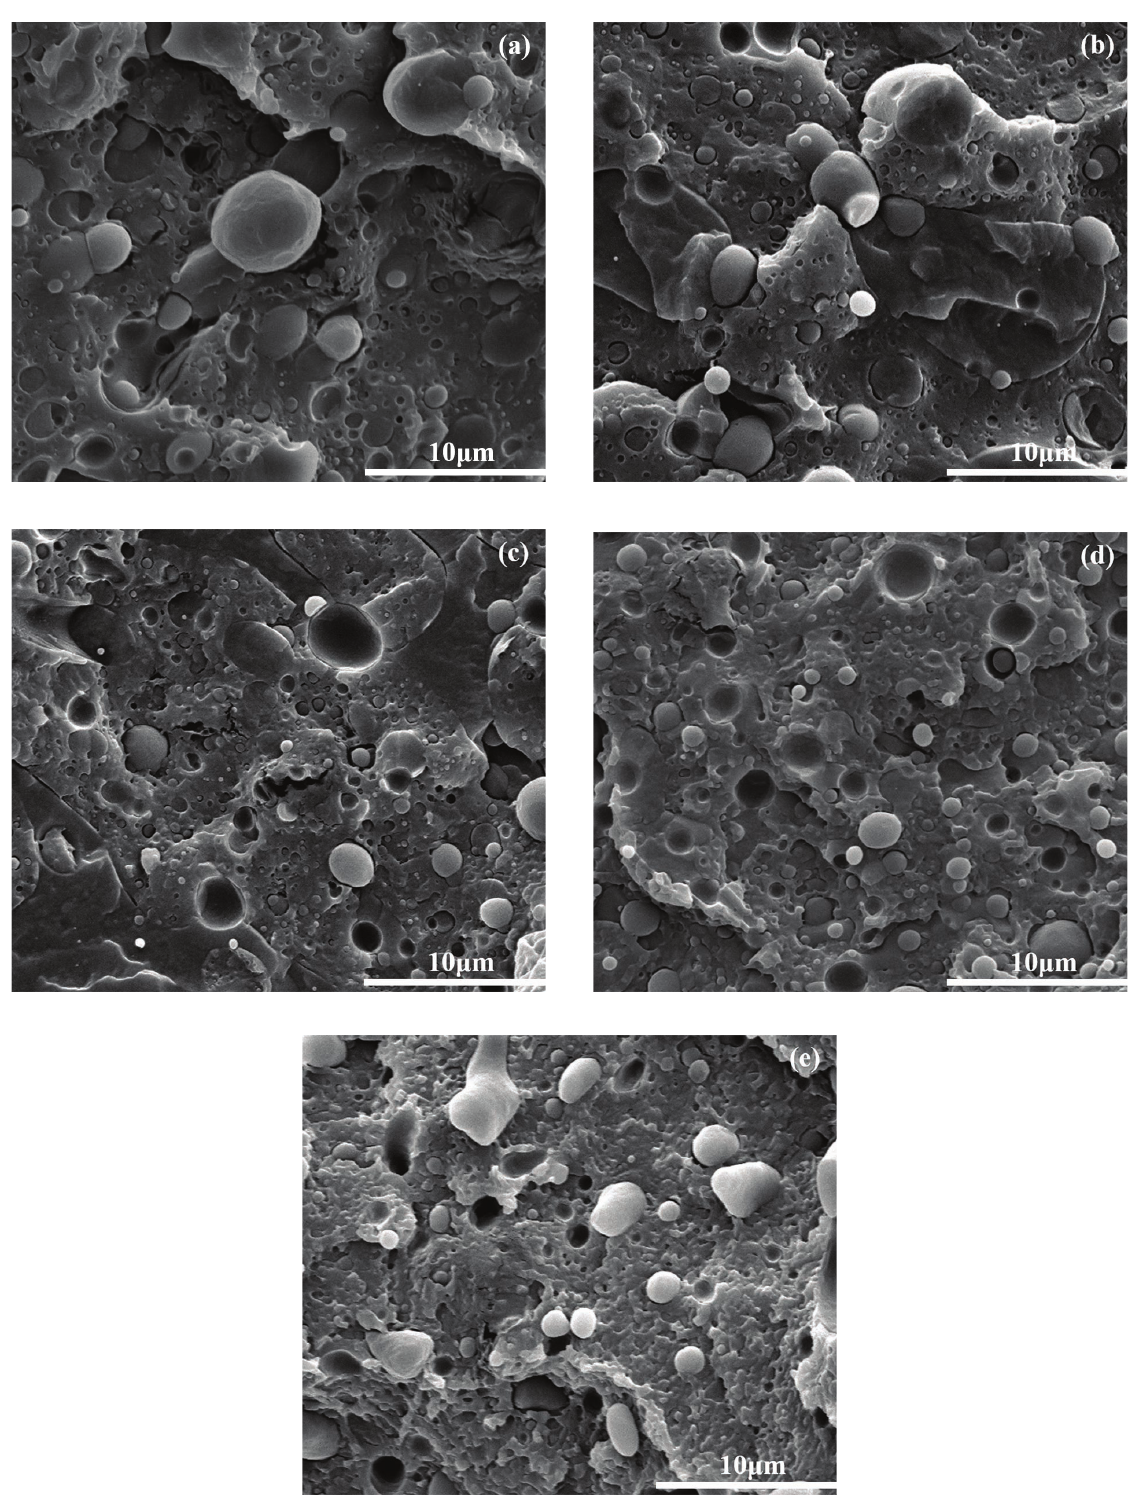
Figure 9: SEM images of the fractured surface morphology (immersion in liquid nitrogen) of the PLA/PBAT blends with different content of ETBP: (a) neat, (b) 0.5 phr, (c) 1.0 phr, (d) 3.0 phr and (e) 5.0